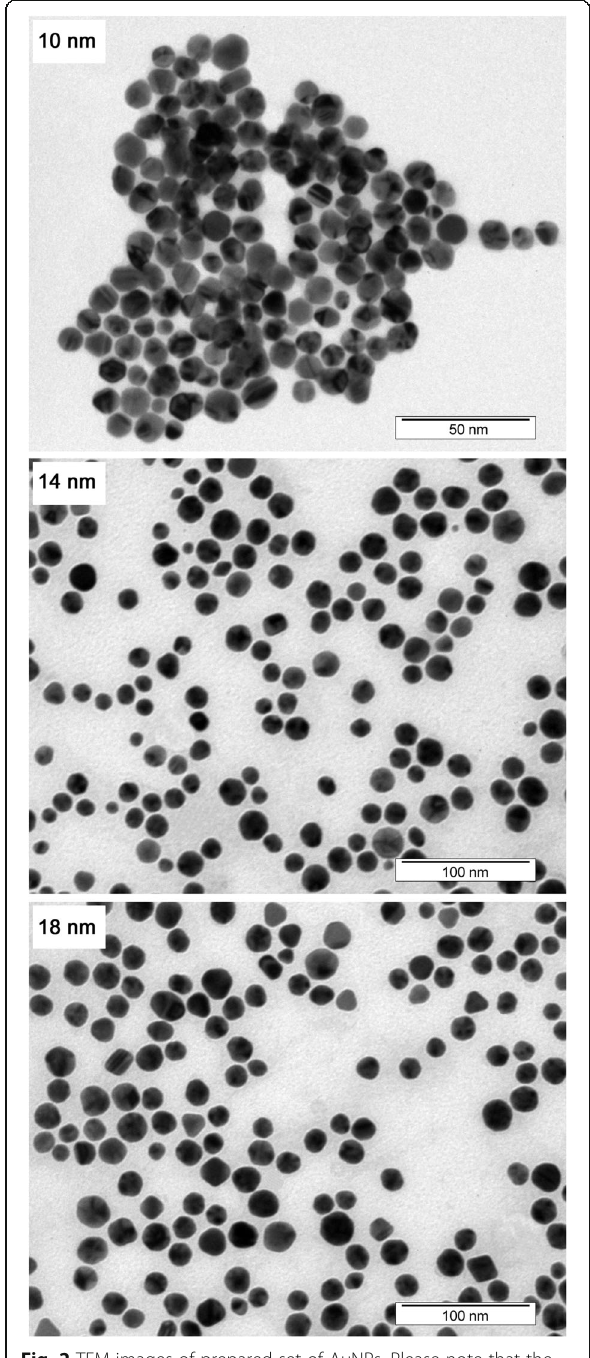
Fig. 2 TEM images of prepared set of AuNPs. Please note that the picture magnification differs for particular NPs